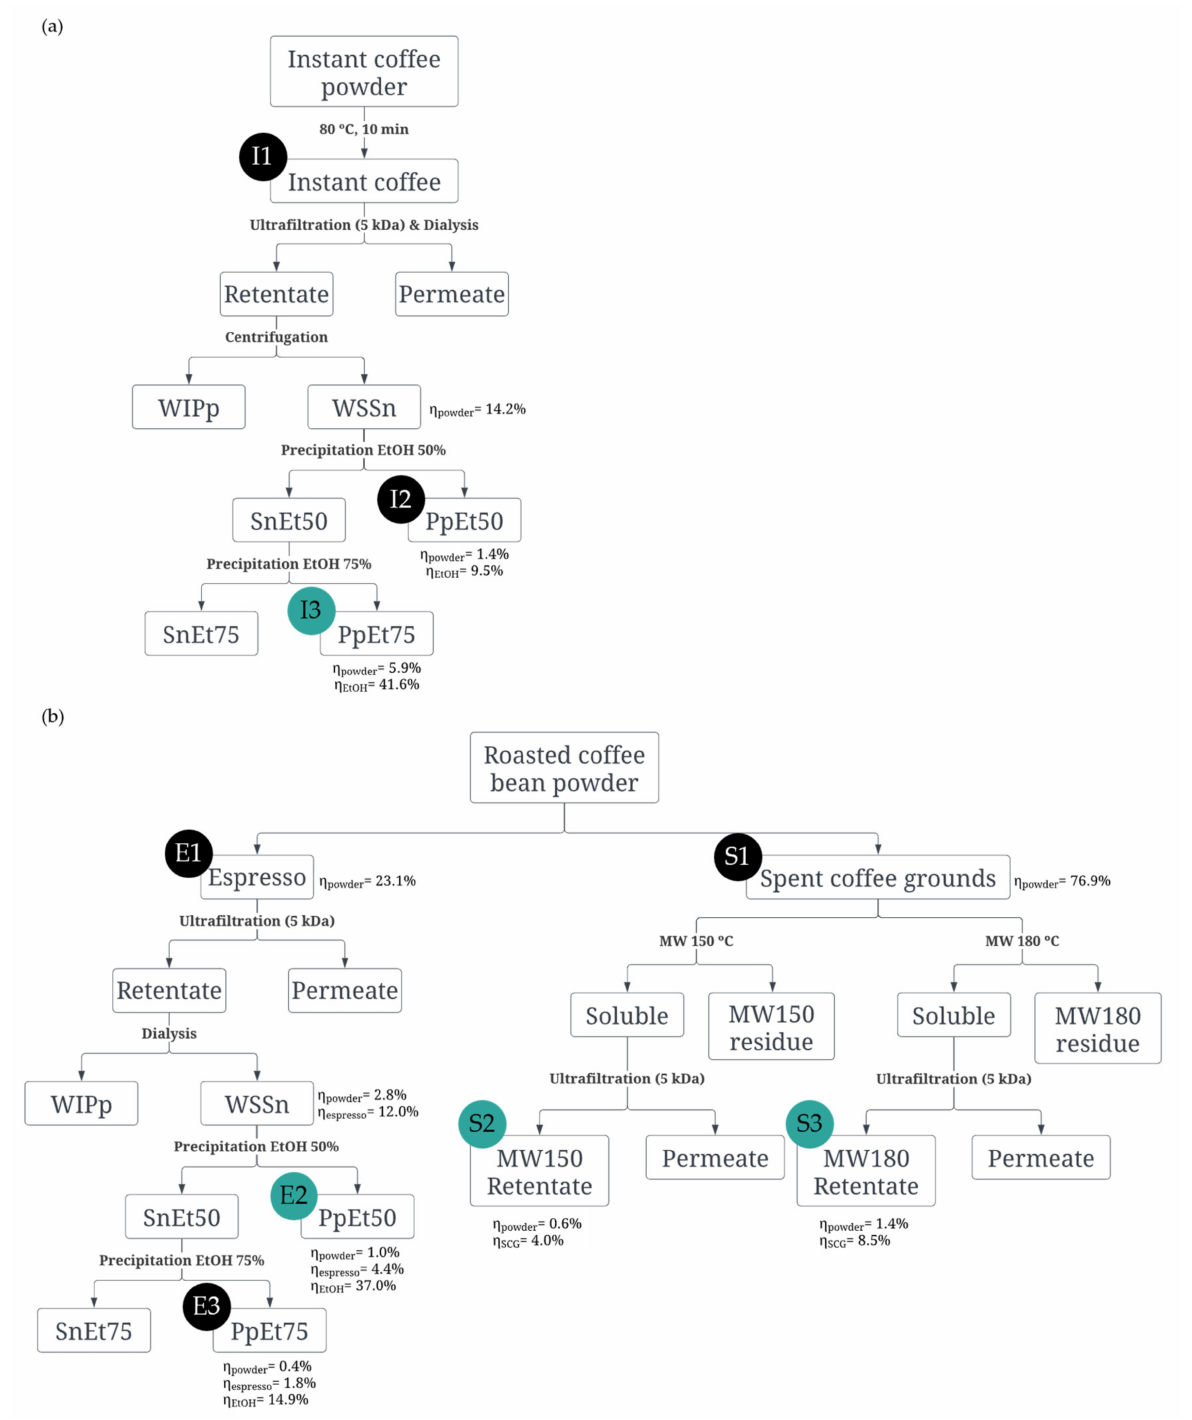
Figure 1. Polysaccharide purification process scheme from ( a ) Instant coffee; ( b ) Espresso coffee and spent coffee